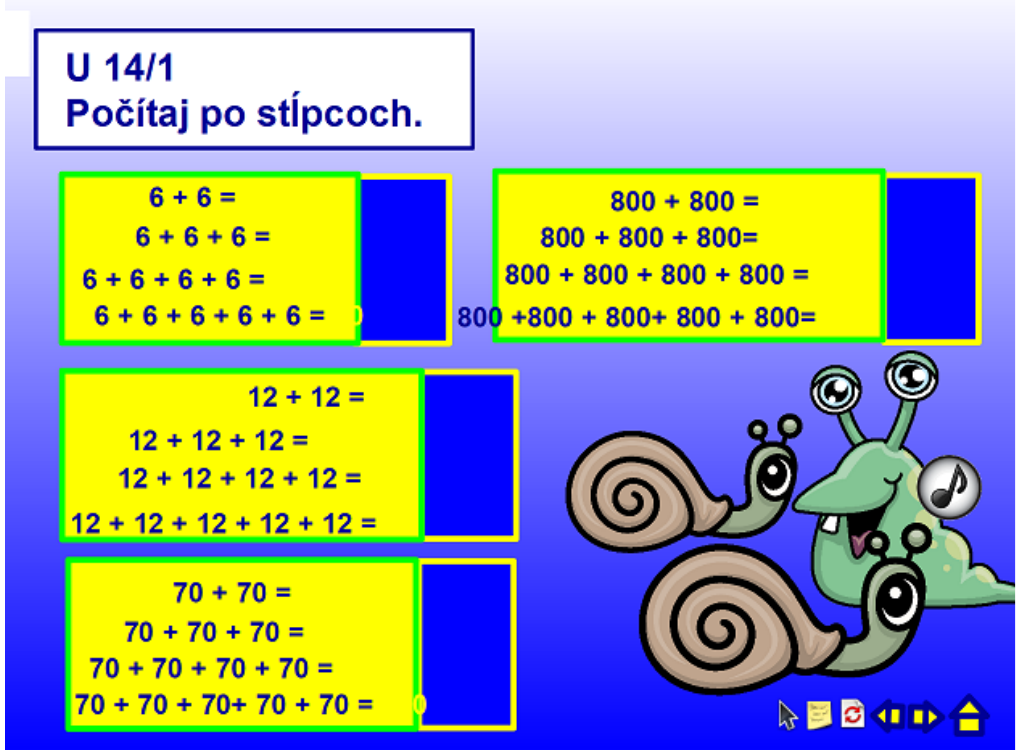
Figure 2. ActivInspire activity inserted via a link in the concept map—multiples of numbers Calculate .